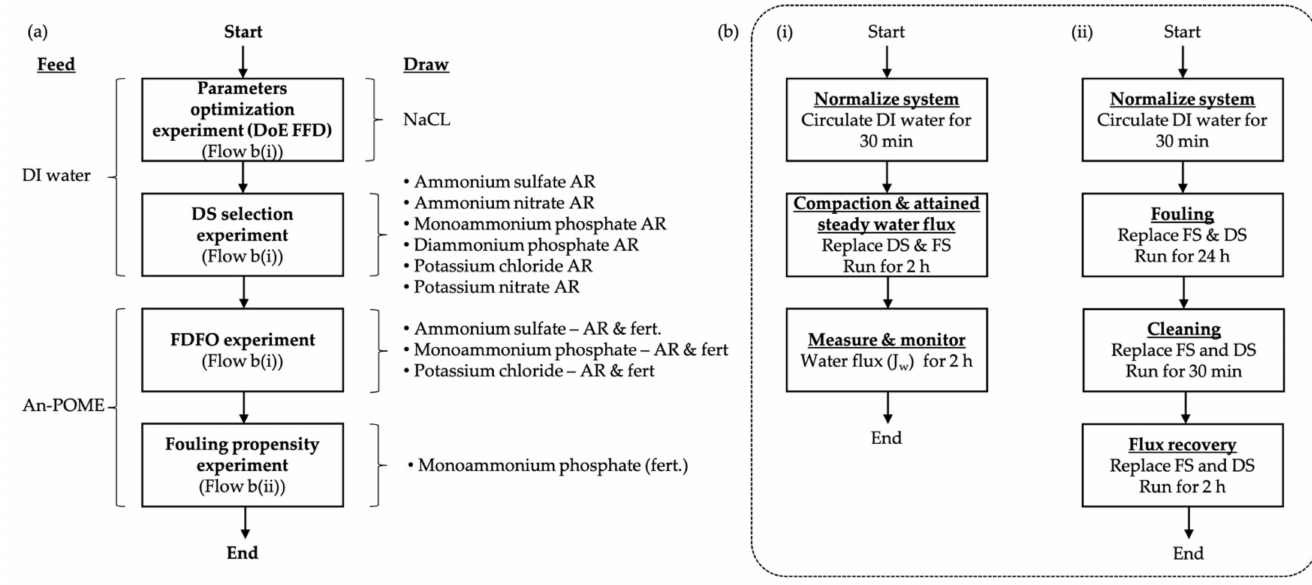
Figure 2. Process flow diagram for ( a ) Research experimental flow; ( b ) FO experiment where ( i ) Basic FO performance experiment; ( ii ) FO fouling propensity